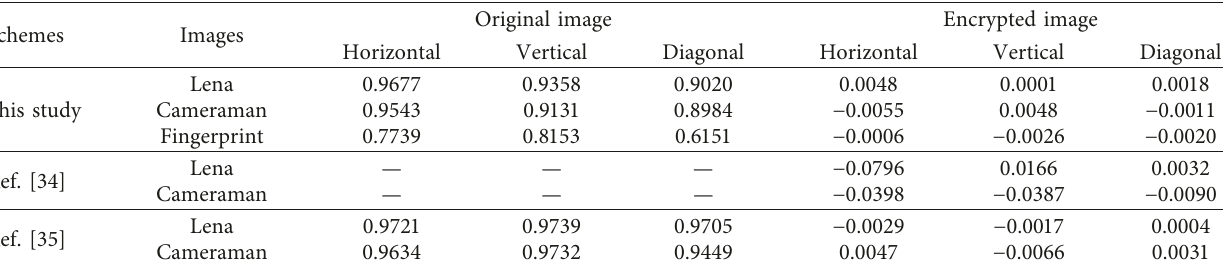
Figure 9: Correlations of adjacent pixels: (a) horizontal, (b) vertical, and (c) diagonal correlations of original image; (d) horizontal, (e) vertical, and (f) diagonal correlations of decrypted image. Table 3: Correlations of original images and encrypted